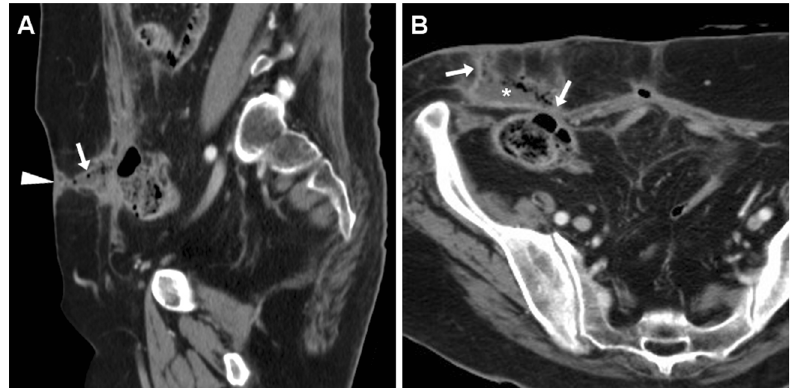
(arrows) between the cecum and an abscess (*) located just superficially to the ventral abdominal muscles, draining to the EFO (arrowhead in A ). Surgical treatment included ileocecal resection and abscess